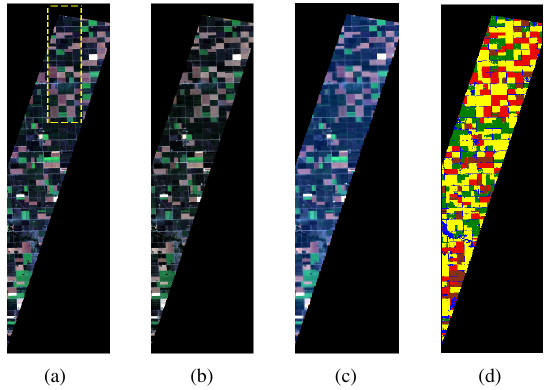
Figure 1: Study Area. (a) True Hyperspectral (THS) image